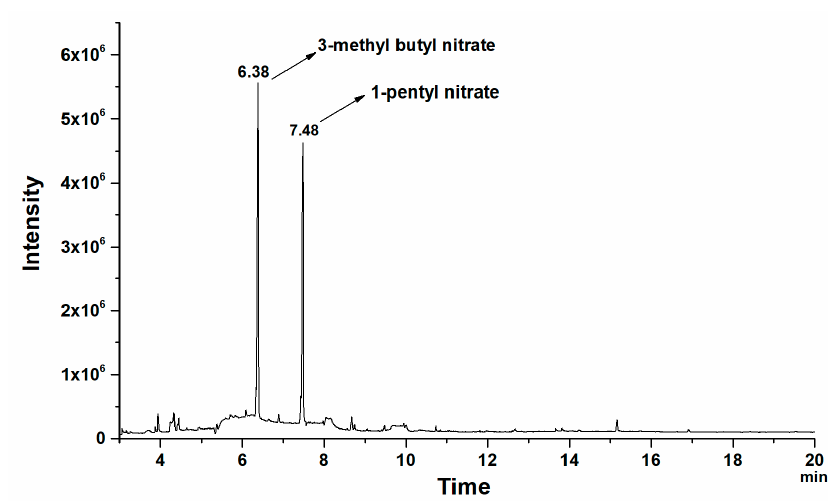
Figure 3. Chromatograms of 1-pentyl nitrate and 3-methyl butyl nitrate.